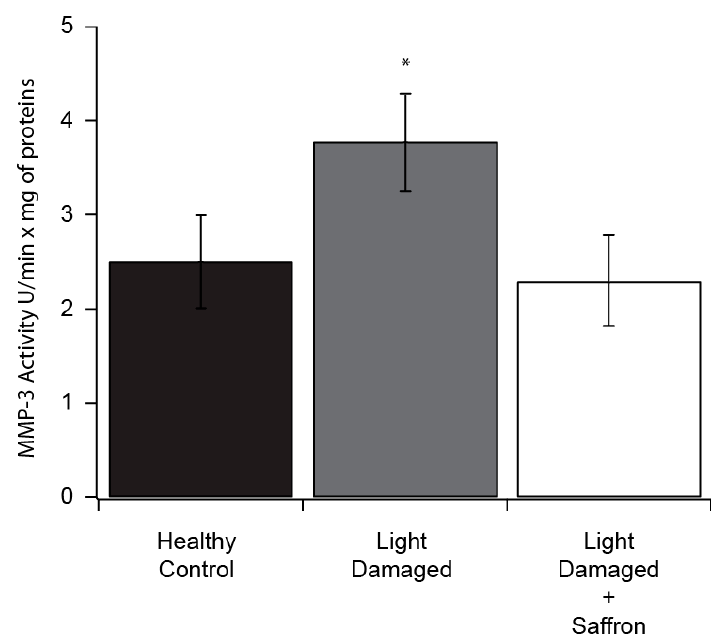
Figure 5. MMP-3 activity measured in retinal extracts of untreated rats (healthy control); rats exposed to light damage (Light Damaged) and rats treated with saffron and exposed to light damage (Light Damaged + Saffron). Results are expressed as the mean ± S.E of four independent experiments. * p < 0.02.